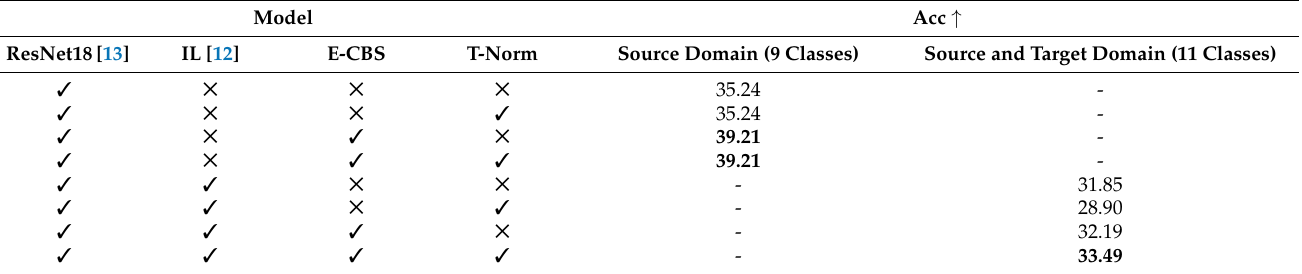
Table 4. Ablation study of the FEN trained in classifying the tissues and instruments found in the source and target